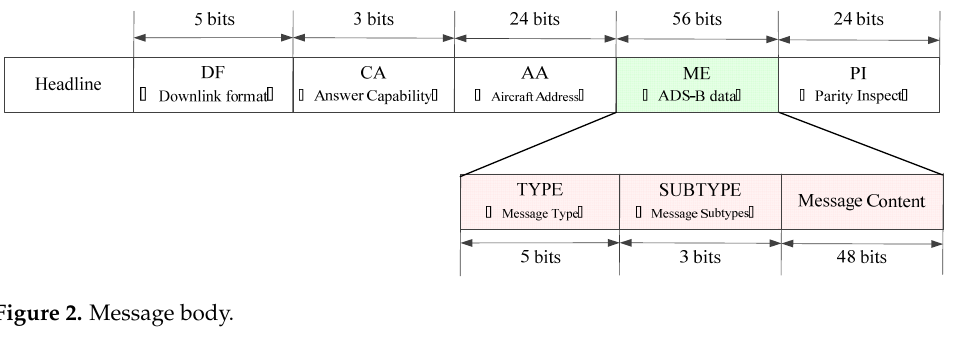
Figure 2. Message Figure 2. Message body.